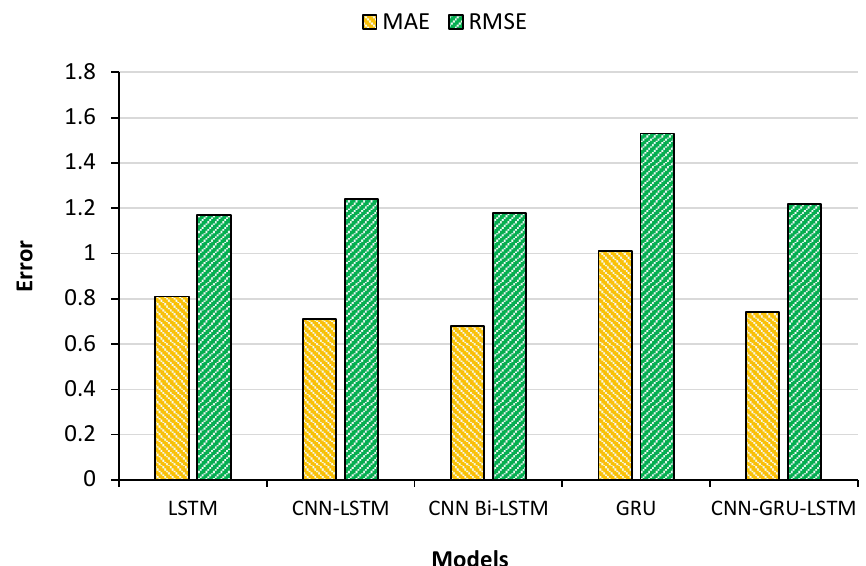
Figure 15. MAE and the RMSE of the five RNN models.